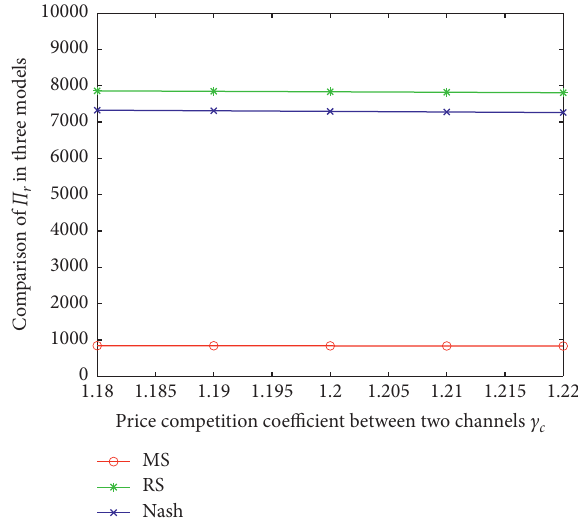
Figure 15: The comparison of the retailer’s profit Π m in the models.